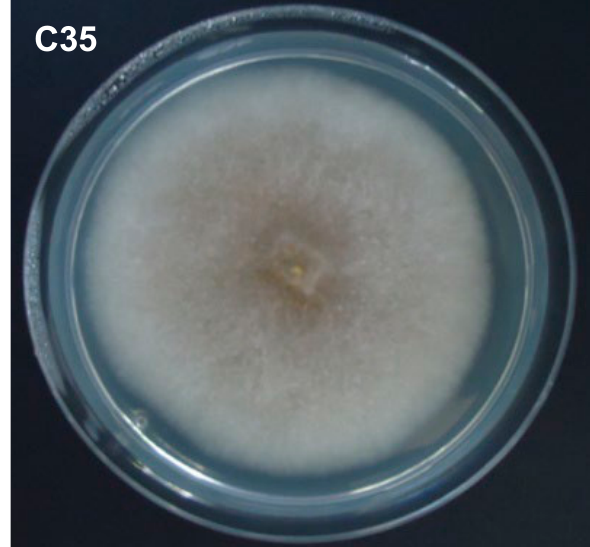
Figure 5. Morphology of Colletotrichum karstii ( C. boninense com- plex) isolate (C35) on PDA plates incubated at 25 °C for 7